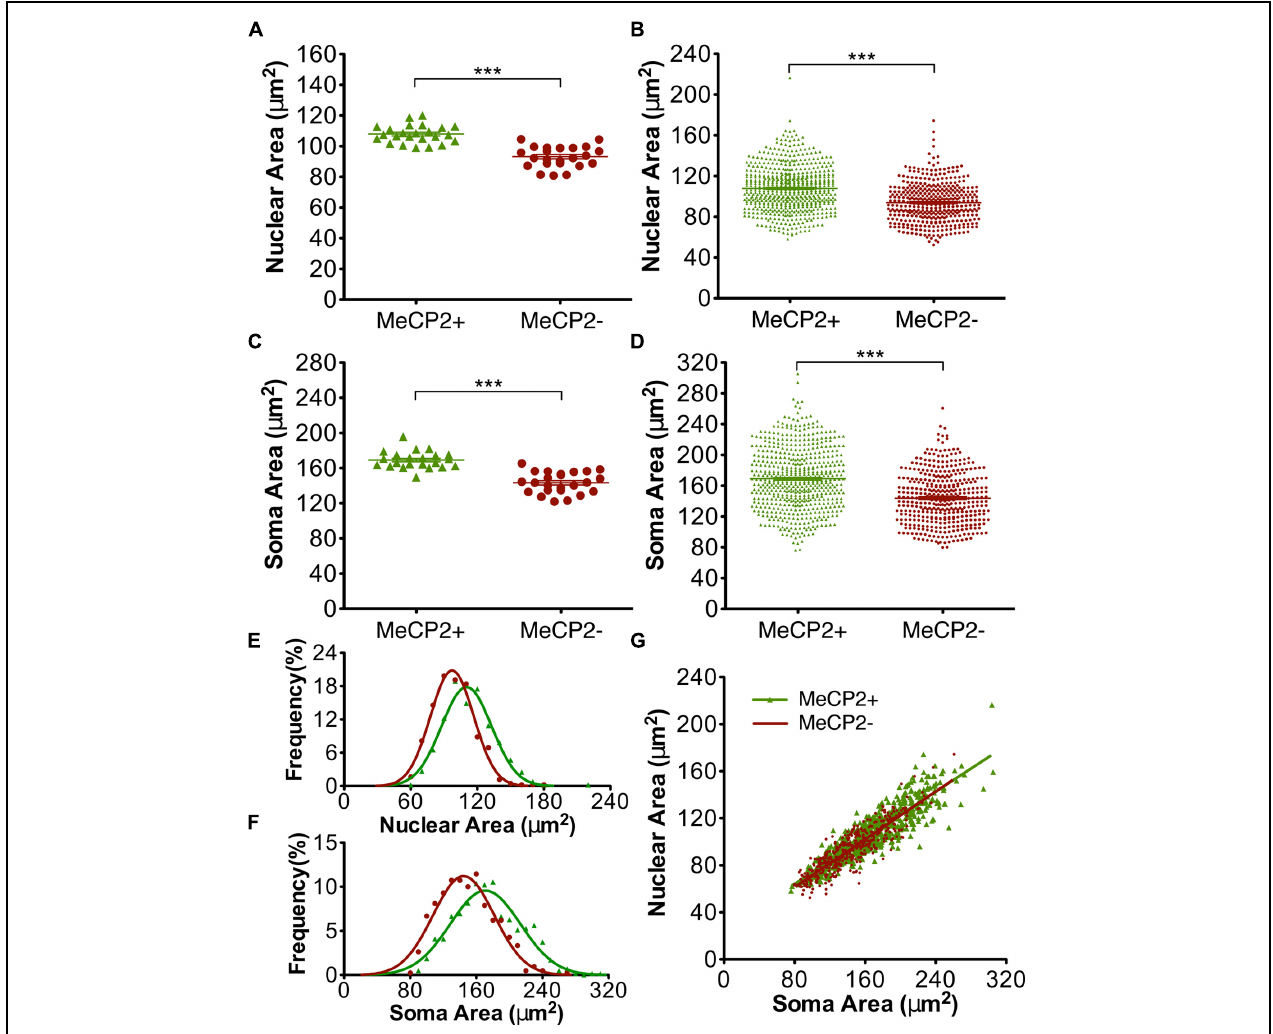
FIGURE 7 | MeCP2 − neurons have smaller somata and nuclei than MeCP2 + neurons. MeCP2 − nuclei (A) and somata (C) are on average 13 and 15% smaller than MeCP2 + nuclei and somata, respectively ( n = 24 animals). The population of MeCP2 − nuclei (B) and somata (D) have fewer large nuclei and somata compared to MeCP2 + (MeCP2 + n = 598 cells and MeCP2 − n = 418 cells). Frequency distributions of